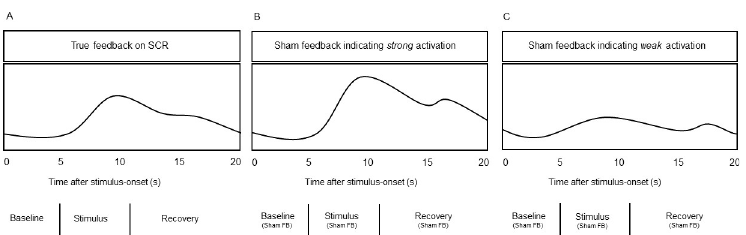
Fig 4. Experimental procedure. Exemplary signal characteristics during Block 1 (true feedback, A) and Block 2 (strong (B) and weak (C) sham